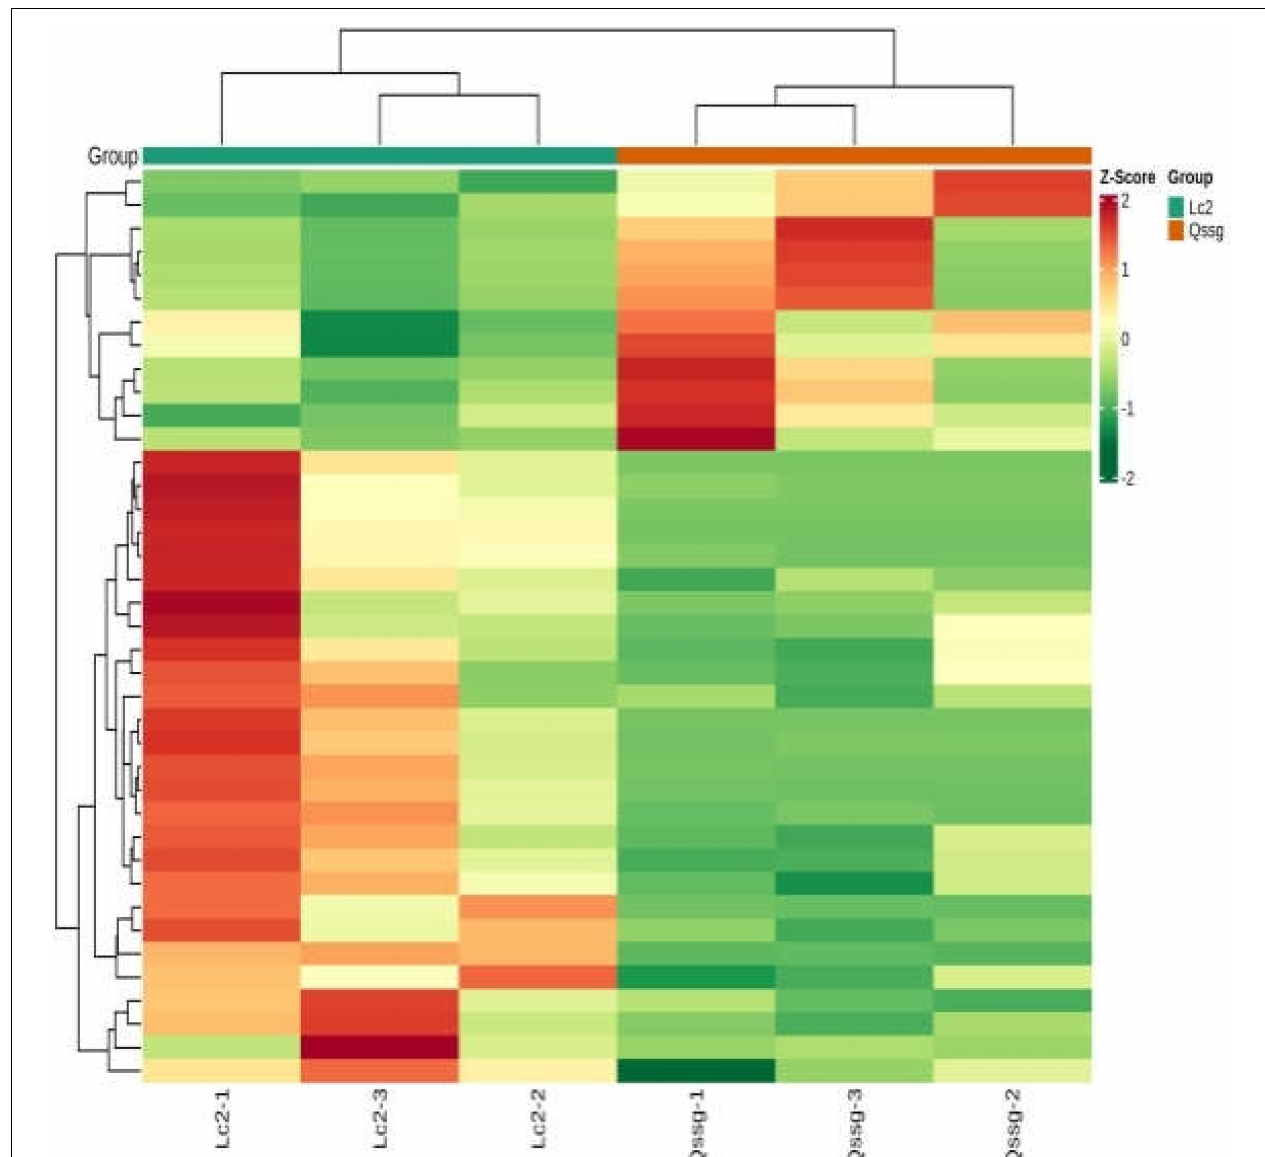
FIGURE 3 | Cluster heat map of metabolites in Qssg and Lc fruits. There are obvious differences between the two